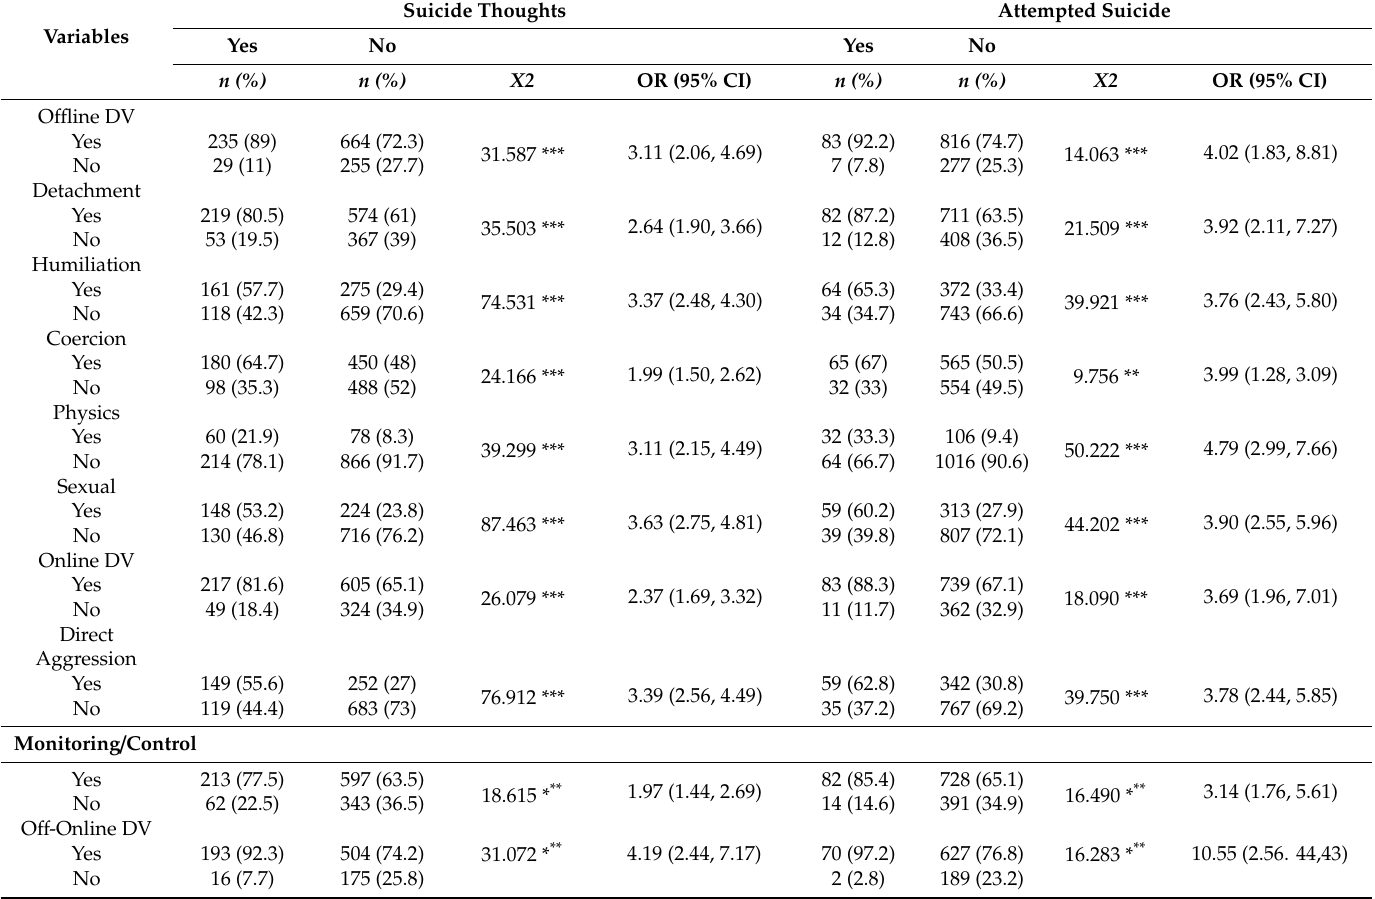
Table 2. Relationship between O ff - and Online DV and Suicidal Ideation and Suicidal